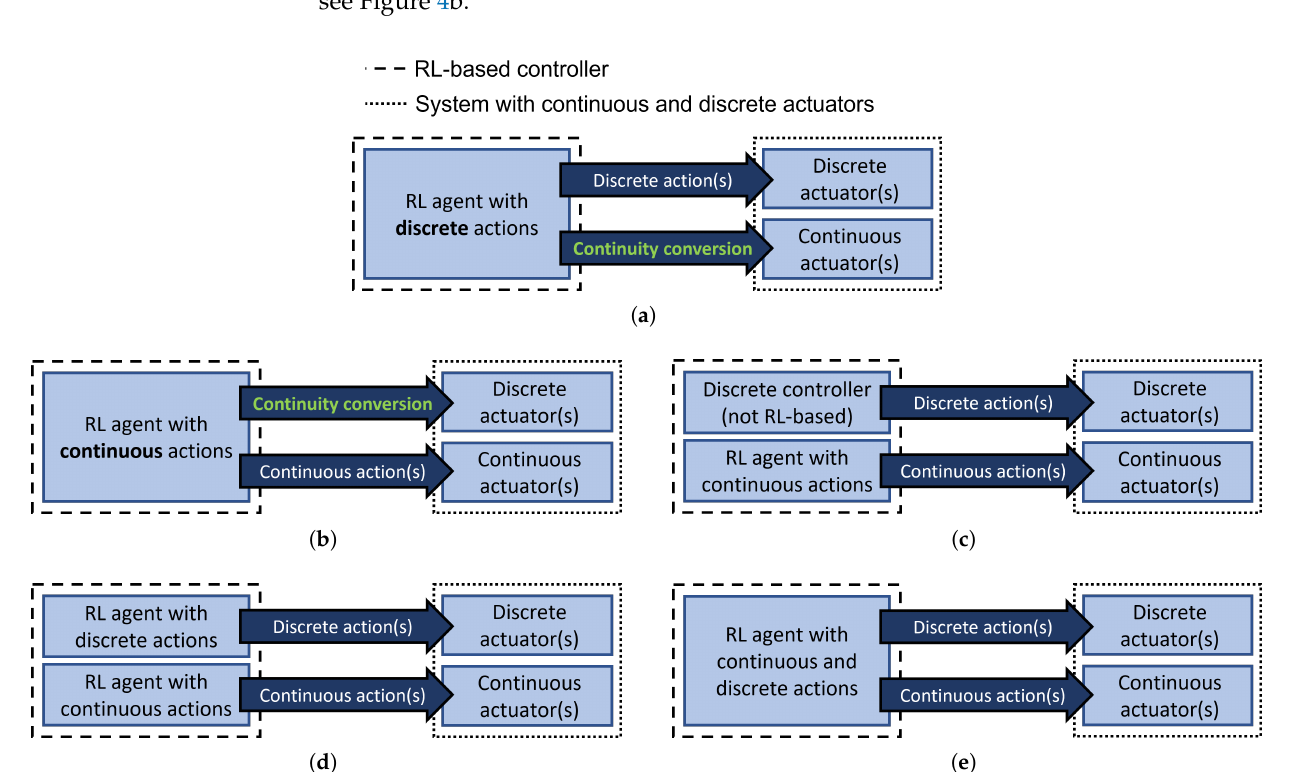
Figure 3. Various ways RL-based controllers can interact with systems containing a mix of continuous and discrete actuators. Implementations include: ( a ) using an RL agent with discrete action outputs and a continuity conversion on some outputs for continuous actuators, ( b ) using an RL agent with continuous action outputs and a continuity conversion on some outputs for discrete actuators, ( c ) using an RL agent with continuous action outputs and a separate rule-based controller for discrete decision making, ( d ) using two RL agents, one with discrete action outputs and the other with continuous action outputs, and ( e ) using a RL agent that has both continuous and discrete action outputs.